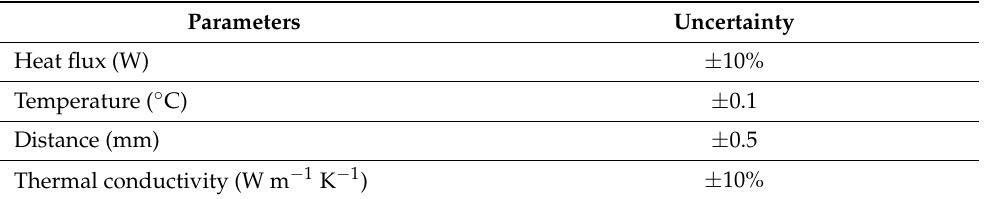
Table 2. Uncertainty of various parameters.